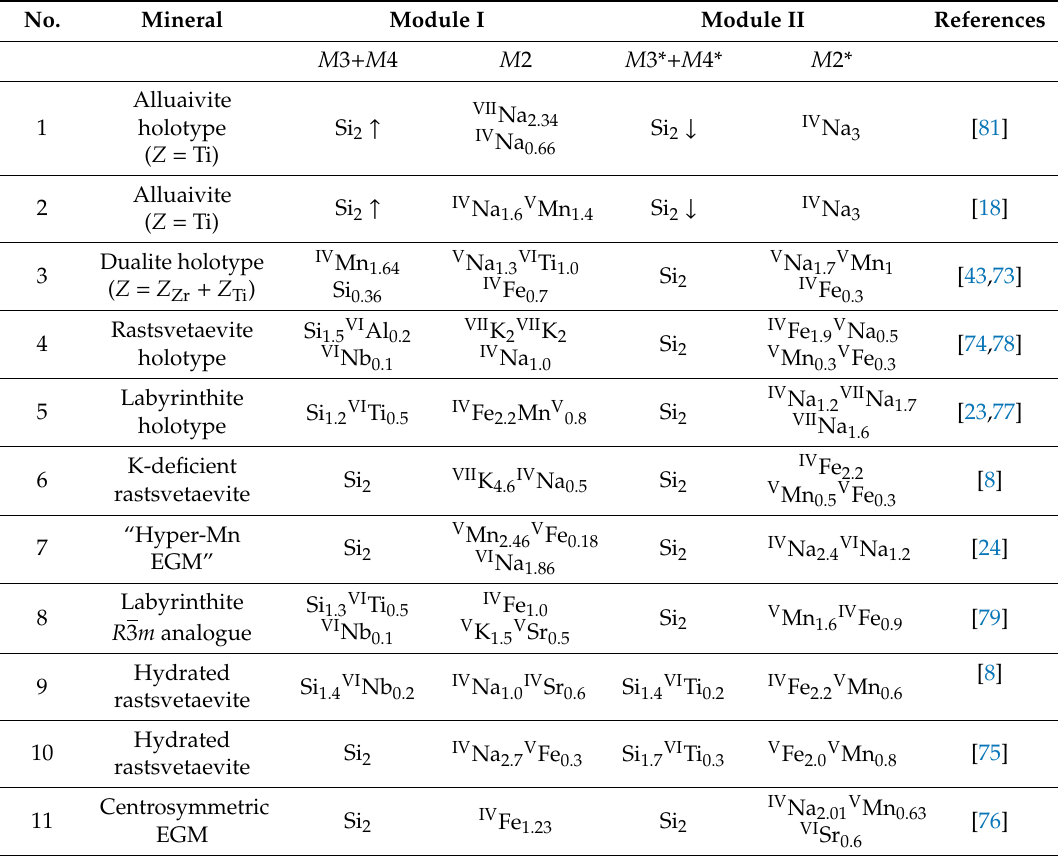
Table 4. Ordered blocky isomorphism at the M 2 and M 3 / M 4 sites of EGMs with modular structures and doubled c parameter ( Z =